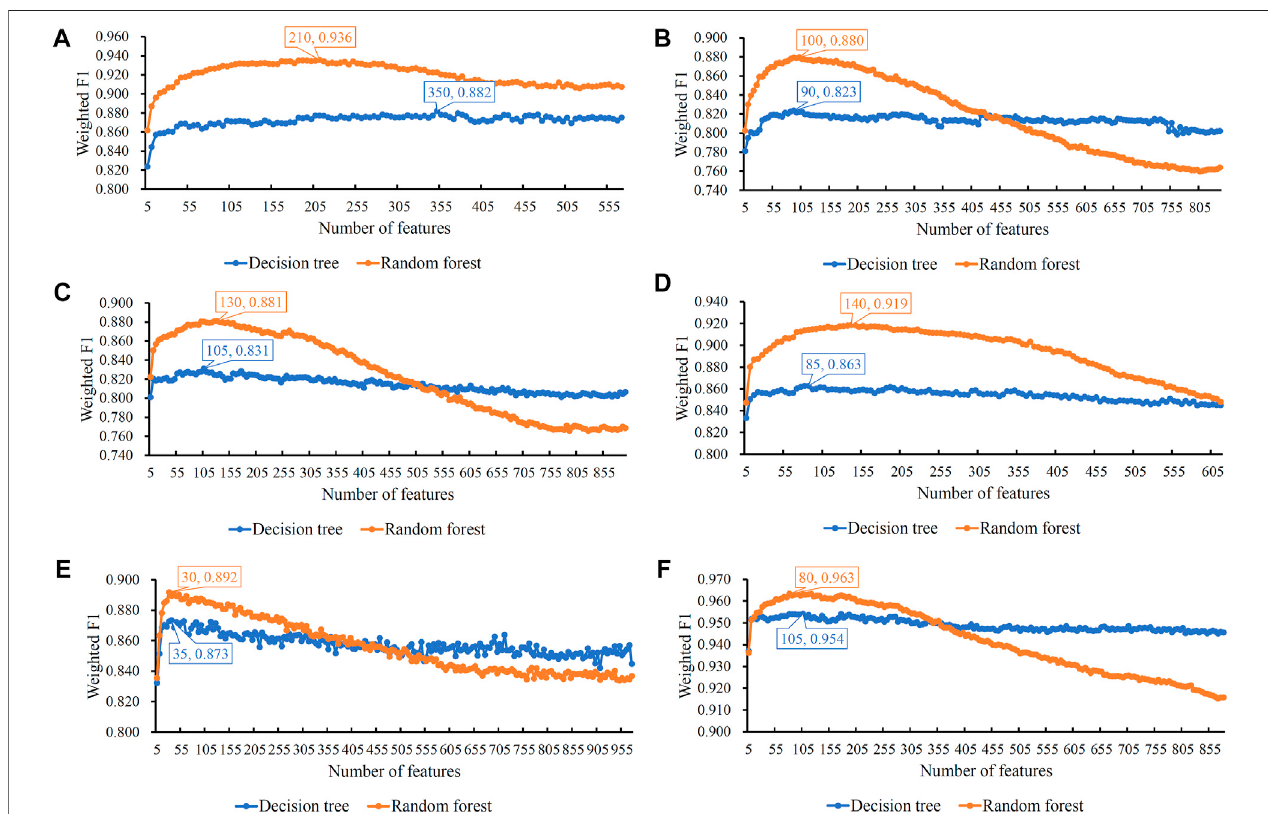
FIGURE 2 | Incremental feature selection (IFS) curves of two classi fi cation algorithms in six cell types. The weighted F1 is set to the Y -axis and the number of features is set to the X -axis. (A) IFS curves in B cells; (B) IFS curves in CD4 + T cells; (C) IFS curves in CD8 + T cells; (D) IFS curves in natural killer cells; (E) IFS curves in dendritic cells; and (F) IFS curves in monocytes. The highest weighted F1 on each curve is marked, along with the number of used features. The random forest can always provide better performance than the decision tree.